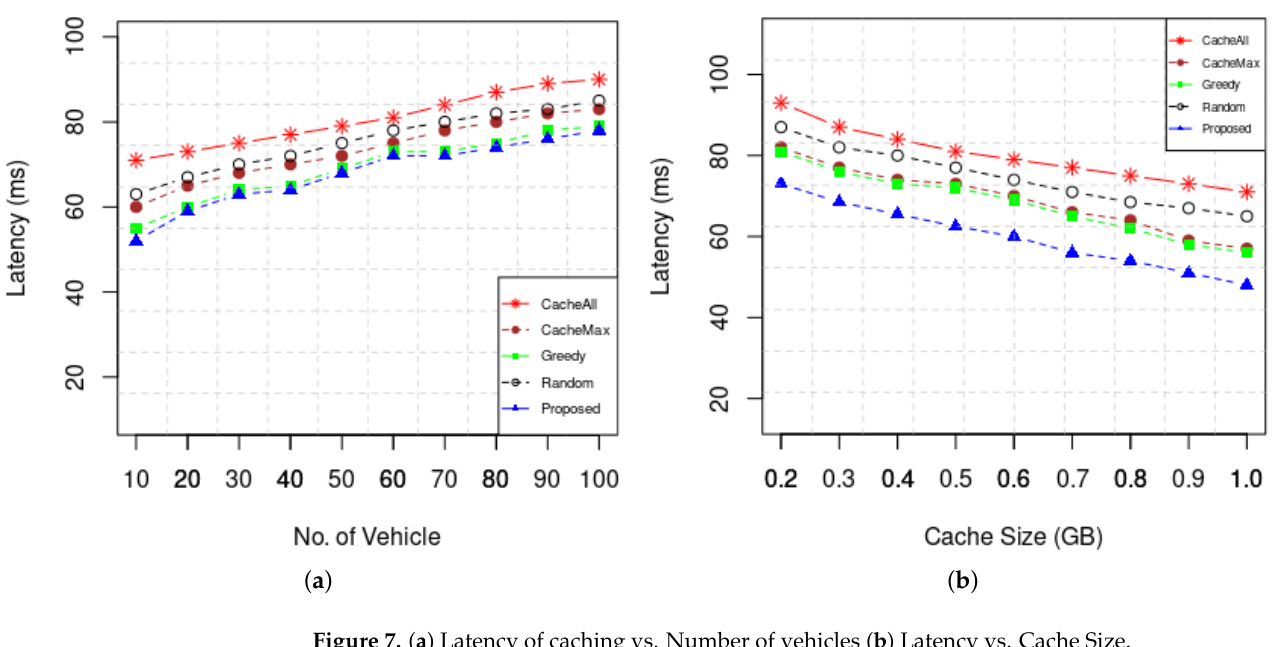
Figure 7. ( a ) Latency of caching vs. Number of vehicles ( b ) Latency vs. Cache Size.